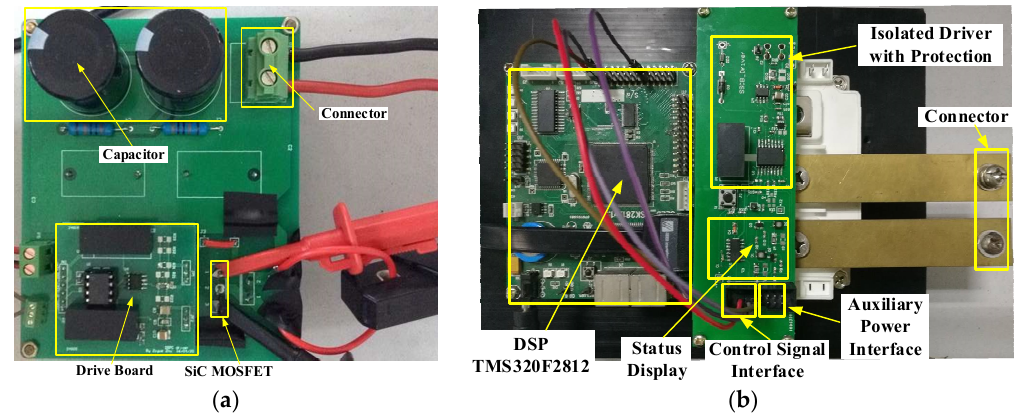
Figure 9. The experiment platform: ( a ) short-circuit TEST platform of MOSFET; ( b ) short-circuit TEST platform of SSCB.